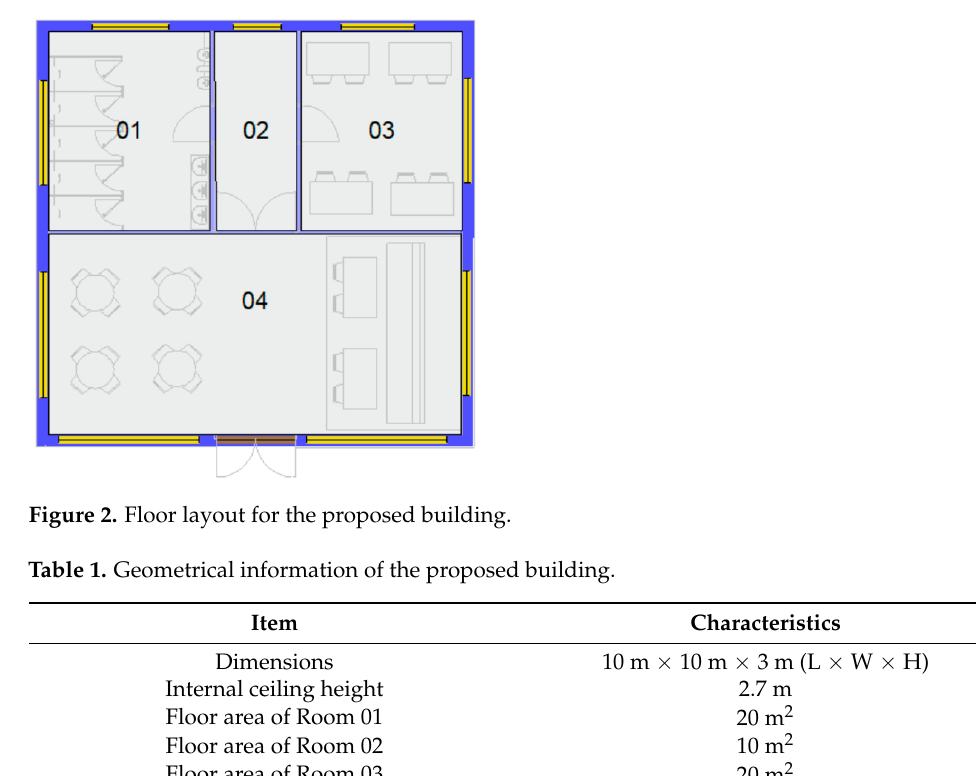
Table 1. Geometrical information of the proposed building.